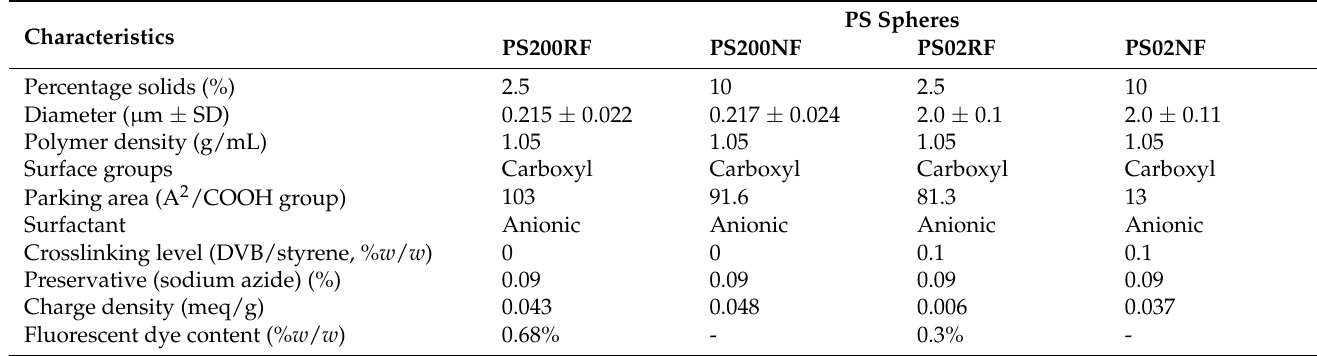
Table 1. Specifications of commercially available PS beads provided by the